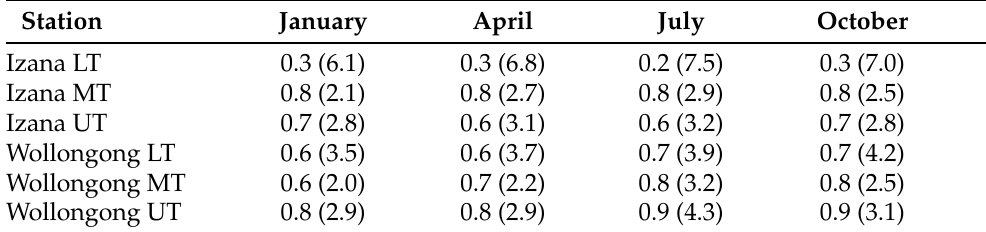
Table 3. Same as Table 2 for NDACC-FTIR N 2 O